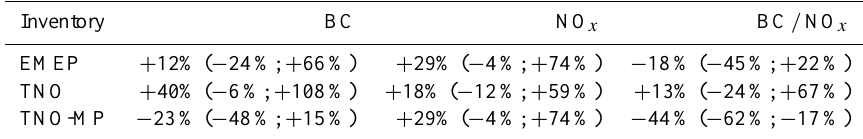
Table 4. Confidence intervals on average emission error biases for the three